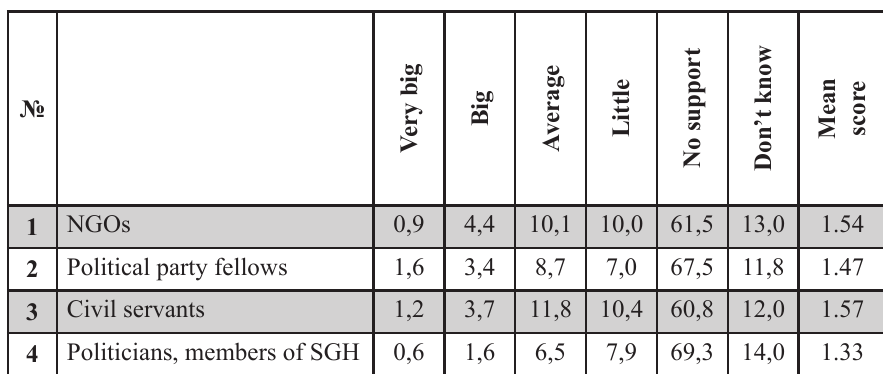
Table 12. Institutional Support to Citizens (percent),